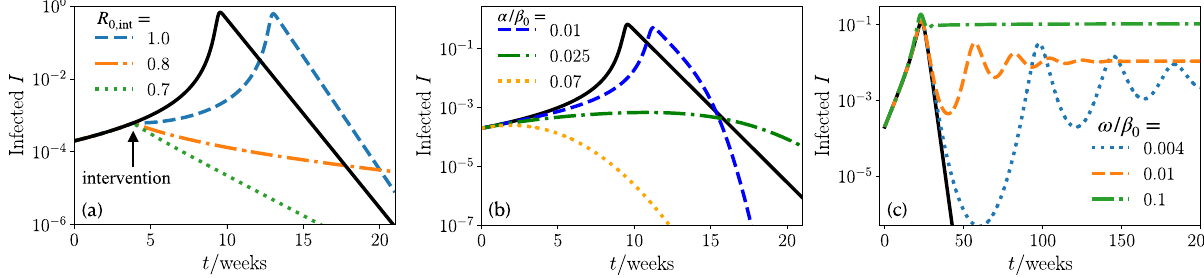
Figure 5. Nonpharmaceutical interventions, vaccinating, and immune escape. ( a ) Infections as function of time for a super exponential wave. Measures are taken by reducing the reproduction number to R 0,int at time t int (black line has no intervention. as function of time of different vaccination rates α (black line has no vaccination. R 0 4 ). ( c ) Infections as function of time of different immune escape rates ω (black line has no immune I 2 10 0 − = × escape. R